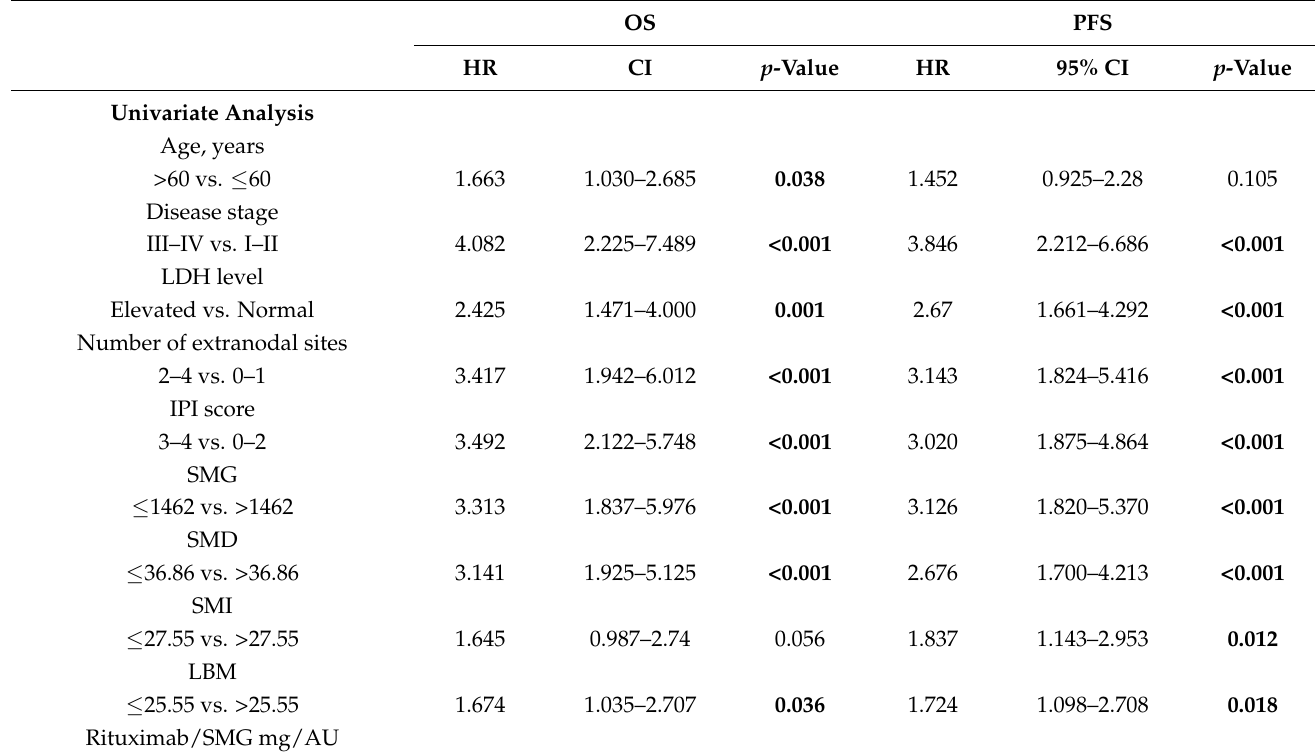
Figure 4. Kaplan–Meier curves of OS for patients by body composition. ( A ) SMG (skeletal muscle gauge), ( B ) SMD (skeletal muscle density), ( C ) SMI (skeletal muscle index), ( D ) LBM (lean body mass). Table 4. Univariate and multivariate analysis for OS and PFS